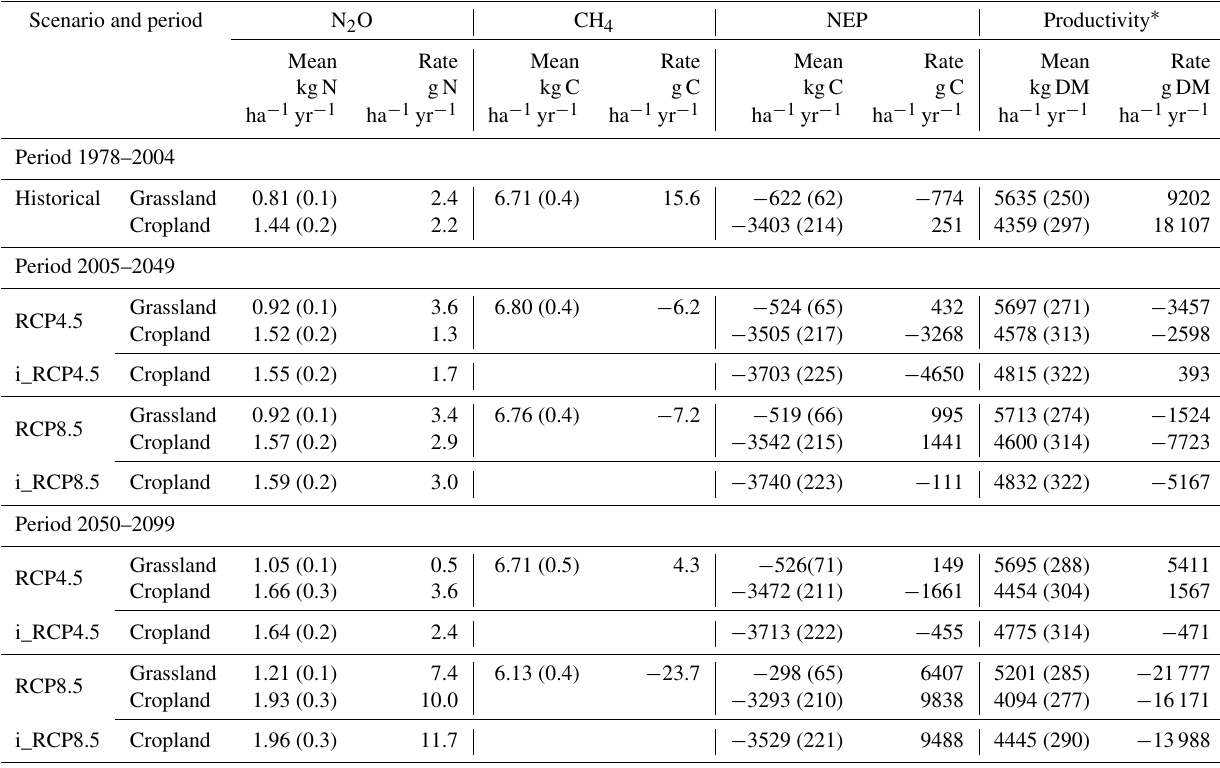
Figure 2. (a) Crop yield trends in Europe from 1978 to 2099 with the two climatic scenarios RCP4.5 and RCP8.5 and two irrigation conditions following the irrigable agricultural area in Europe or extending the irrigation to all the arable lands (i_RCP4.5 and i_RCP8.5); all crops confounded. (b) Grassland yield reported as aboveground biomass (AGB), which is the sum of biomass mowed and ruminant intake. Table 1. Emissions of N 2 O and CH 4 , the net ecosystem production (NEP; for the sign convention, negative values represent a stock of carbon), and productivity from grassland and croplands. Between brackets is the standard